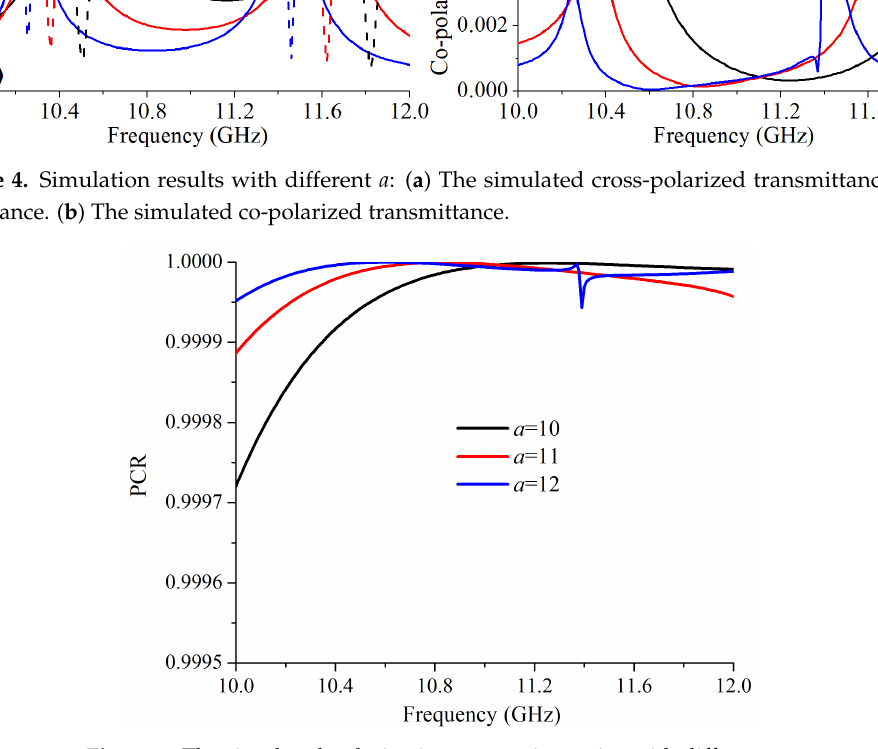
Figure 5. The simulated polarization conversion ratios with different a .